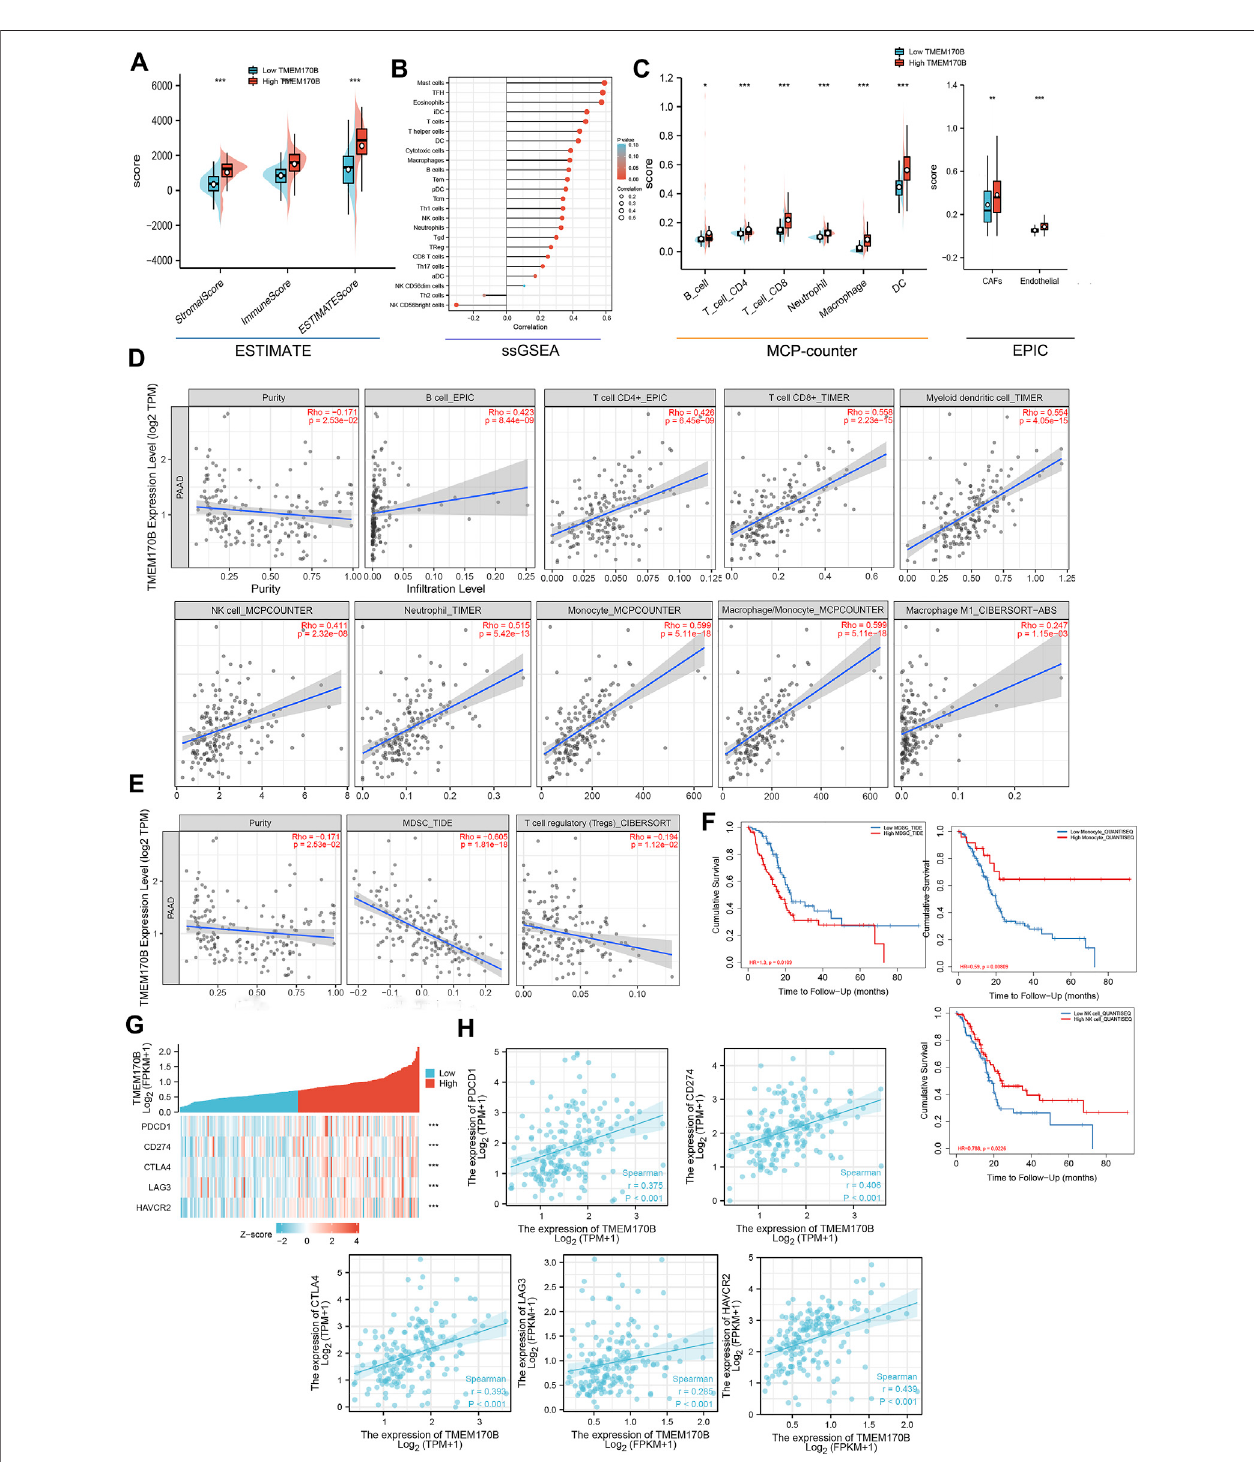
FIGURE 7 | Correlation analysis between TMEM170B expression and immune in fi ltration of multiple immune cells. (A) Violin plot showing the differential StromalScore, ImmuneScore, and ESTIMATEScore of high and low TMEM170B expression. (B) The correlation between TMEM170B expression level and 24 immune cell types. (C – D) The correlation between TMEM170B expression and antitumor immune cell in fi ltration, including that of B cells, CD8 + T cells, CD4 + T cells, myeloid dendritic cells, natural killer cells, neutrophils, monocyte and M1 macrophages. (E) The correlation between TMEM170B expression and the in fi ltration of immunosuppressive cells, including myeloid-derived suppressor cells and regulatory T cells. (F) Kaplan-Meier analysis results based on the extent of monocyte, natural killer cells and yeloid-derived suppressor cells in fi ltration in PAAD. Red represents high immune cells in fi ltration, and blue represents low immune cells in fi ltration. (G,H) The gene-by-gene correlation analysis of common ICP genes and TMEM170B expression. * p < 0.05; ** p < 0.01; *** p < 0.001.